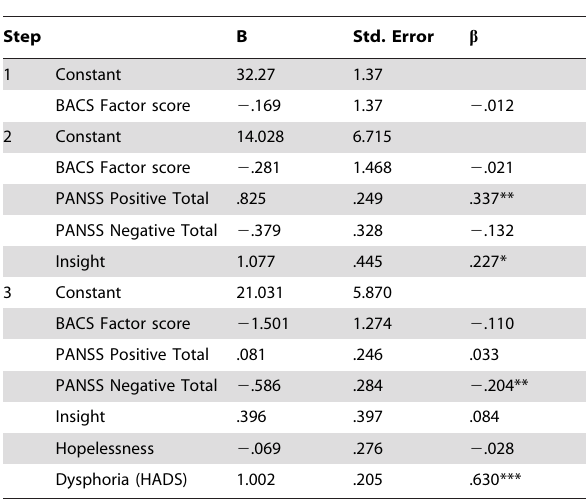
Table 5. Multiple regression analysis 1. Table 6. Multiple regression analysis 2 (inclusion of duration of psychosis and medication